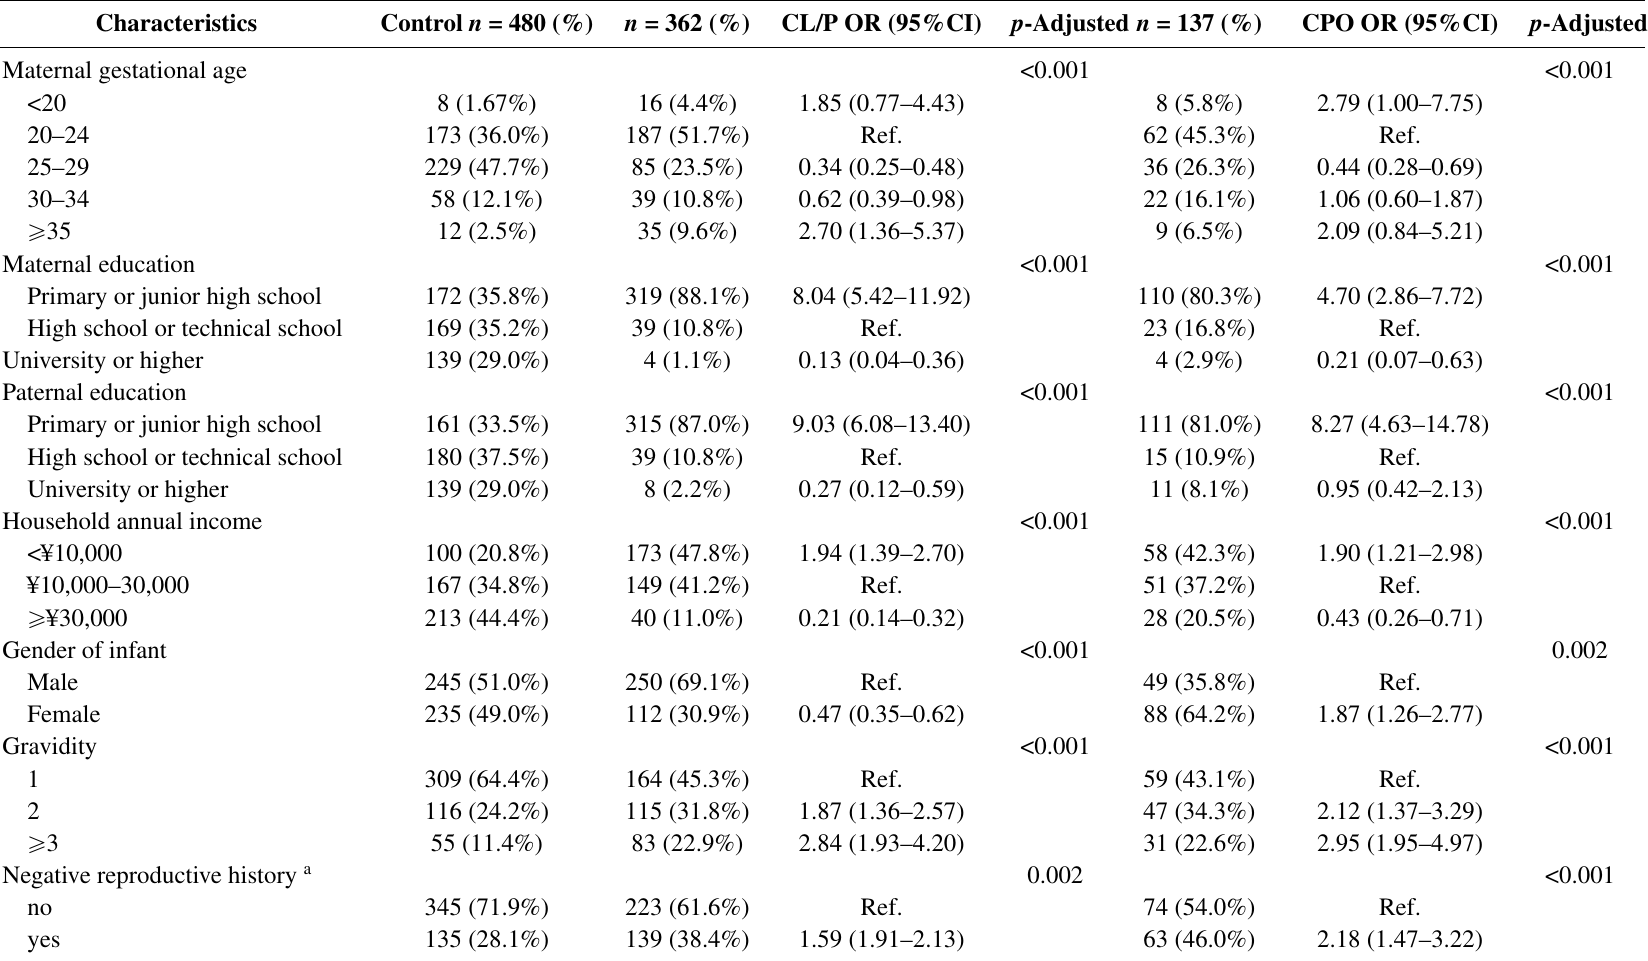
Table 1. Demographic characteristics of 499 case and 480 control